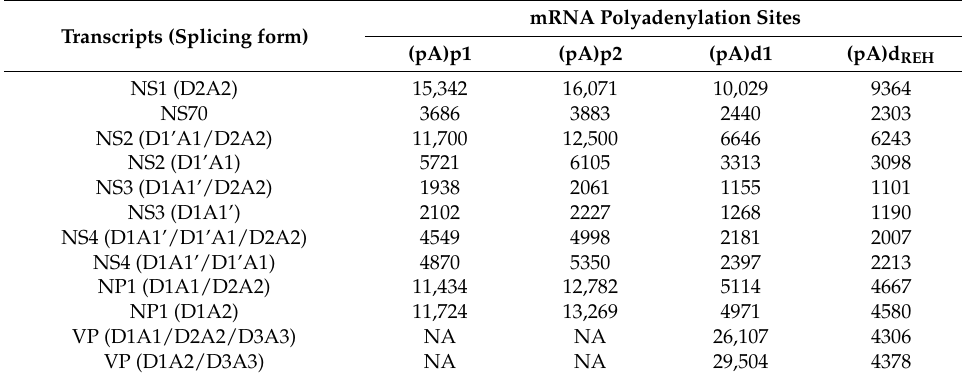
Table 3. Assembled HBoV1 mRNA transcripts and expression